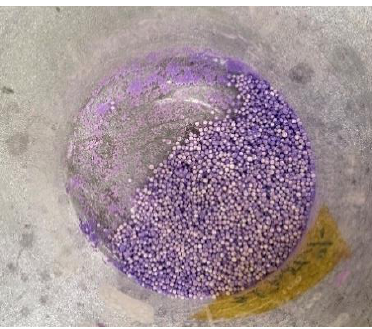
Figure 8. Complete diagram of the prepared Co 2+ /Al 2 O 3 catalyst.